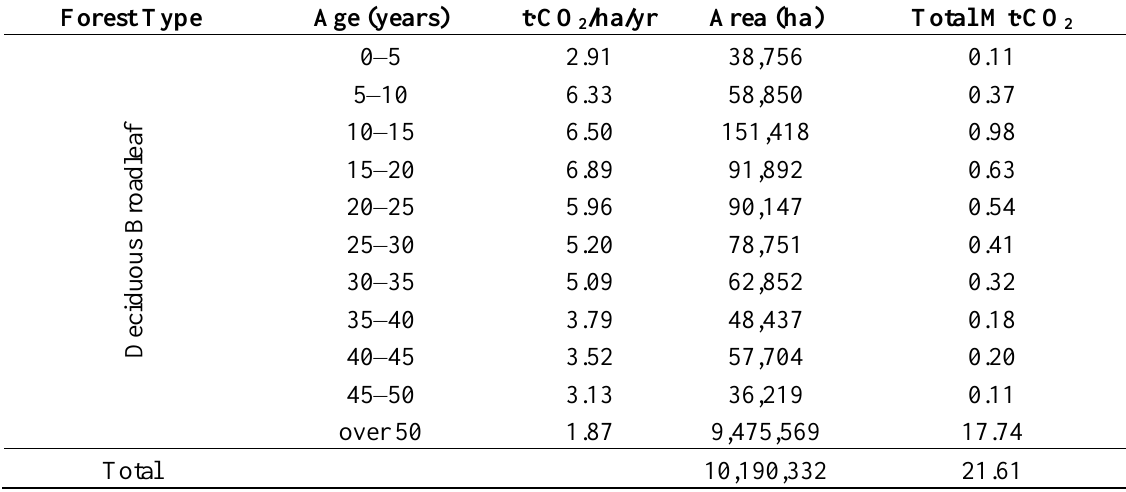
Table 4. CO 2 sequestration of deciduous broadleaf forests by tree age using the PALSAR data and the stem volume method.